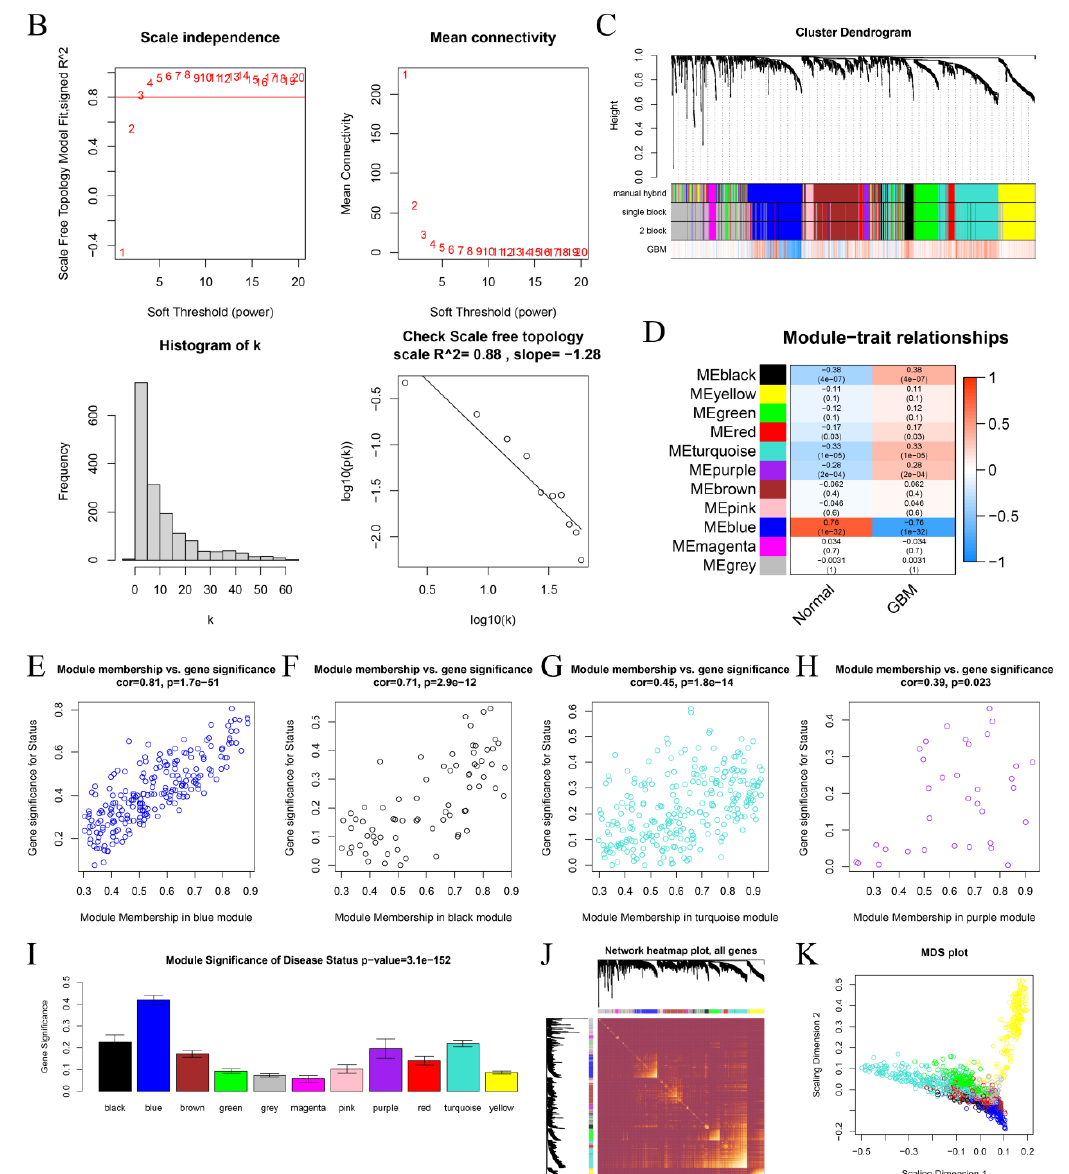
Figure 2. Associated module connected to clinical characteristic recognition. ( A ) Trait heatmap and sample dendrogram. Color intensity indicates patient condition. ( B ) Scale-free fit index analysis of soft-thresholding powers ( β ); mean connectivity index analysis of soft-thresholding powers; histo- gram of frequency distribution when β = 3; check scale-free topology when β = 3. ( C ) Dendrogram of clusters of differentially expressed genes based on dissimilarity measure (1-TOM). ( D ) Heatmap showing relationship between module eigengenes and ccRCC clinical data. ( E – H ) Scatter diagrams of gene module membership correlation in blue, black, turquoise, and purple modules with gene significance. ( I ) Average gene significance distribution in modules linked to GBM illness status. ( J ) Network heatmap plot for all genes in WGCNA. ( K ) Traditional MDS plot with TOM dissimilarity as its input. Module assigns color for each gene-designated dot.